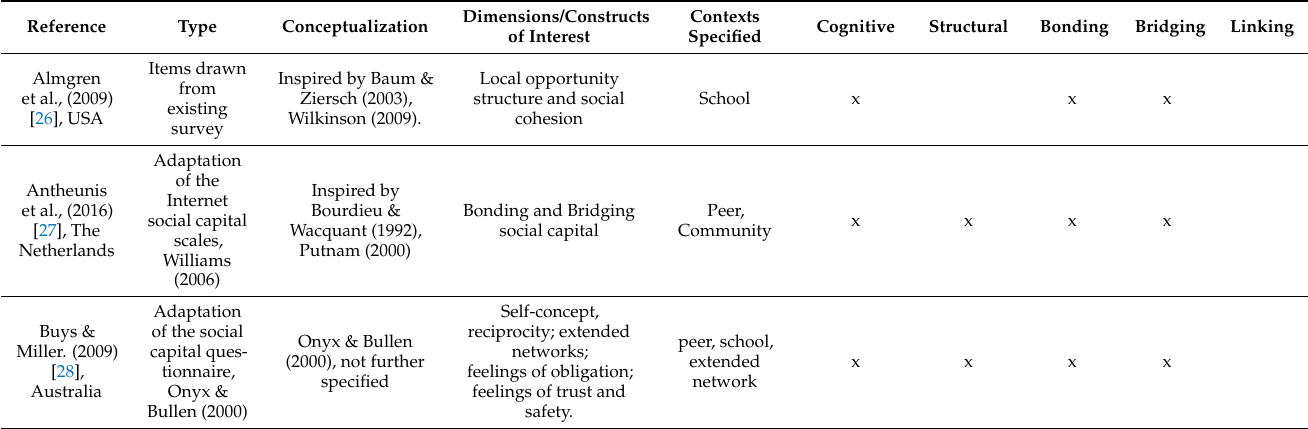
Table 2. Type of instrument, conceptualization, dimensions, constructs and